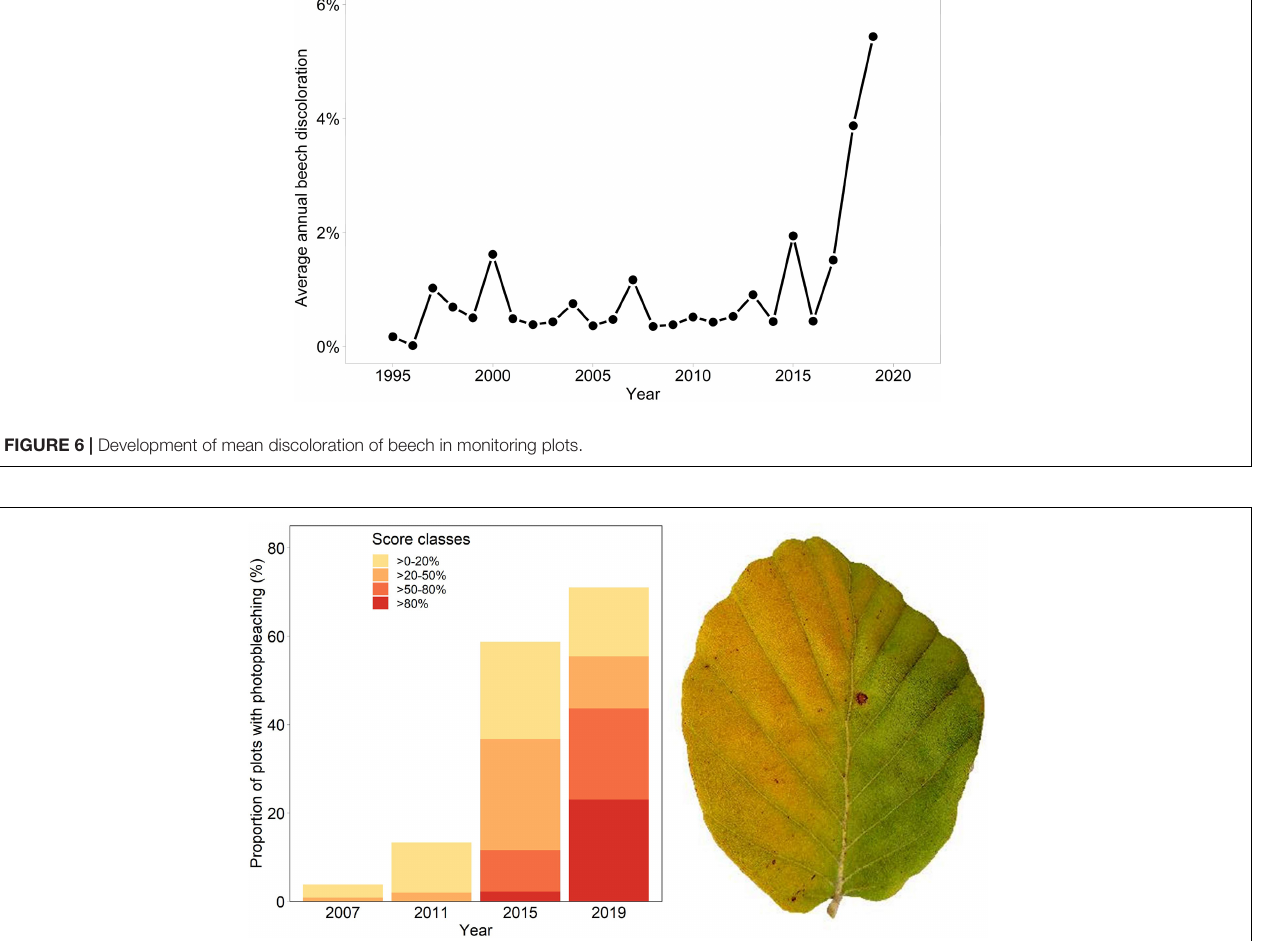
Frontiers in Forests and Global Change |